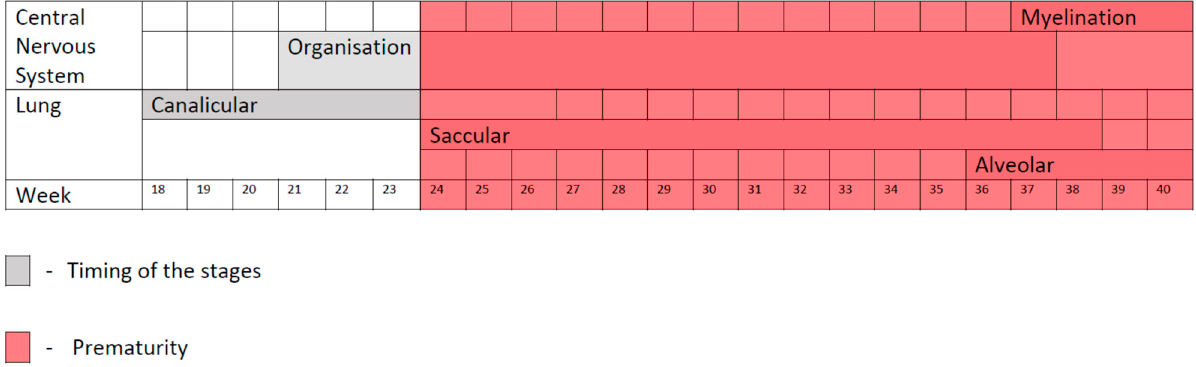
Figure 1. Central nervous system and lung development.